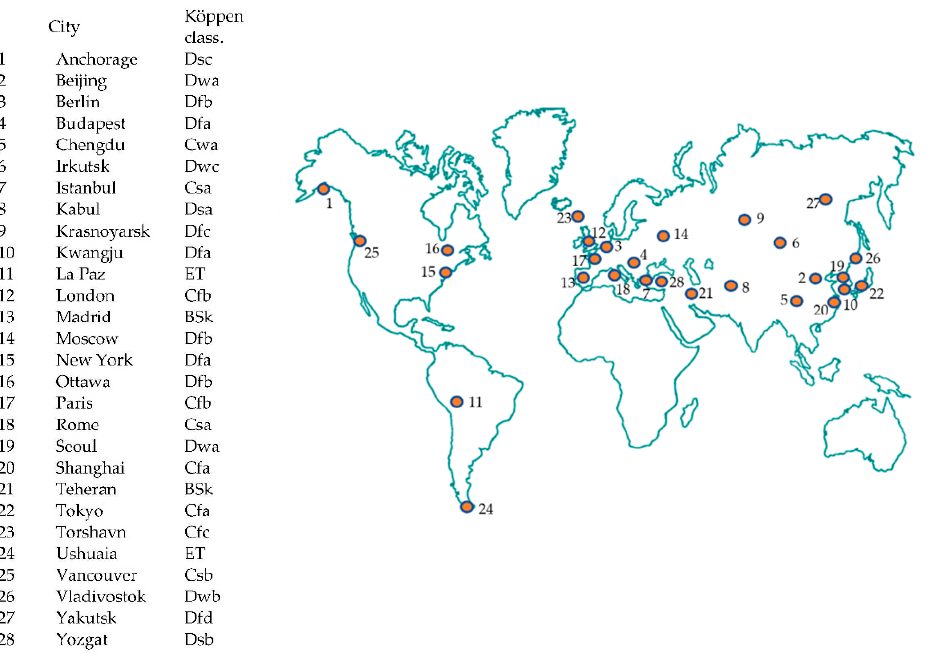
Figure 1. Cities selected to study the effect of climate on thermal performance of radiant wooden floor heating.